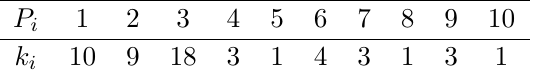
Table 3 . List of highest symbolic exponents k i such that the associated symbolic power P h k i i be computed to construct the Ansatz for the rational prefactors in R (2 , 0) in eqs. (5.7) to